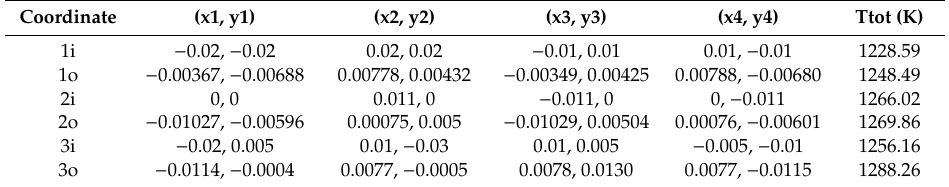
Table 6. Initial and optimized layout